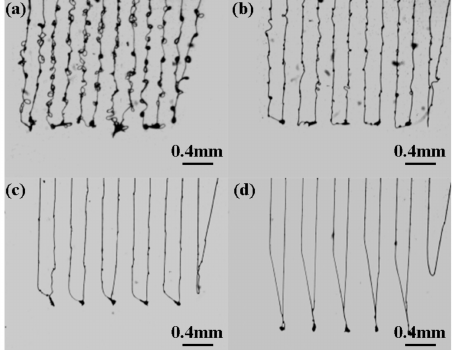
Figure 7. Direct-written patterns at the turning point under collector moving speed. ( a ) 1 mm/s; ( b ) 5 mm/s; ( c ) 10 mm/s; ( d ) 20 mm/s. The assisted airflow and the applied voltage were 25 kPa, 2.0 kV,